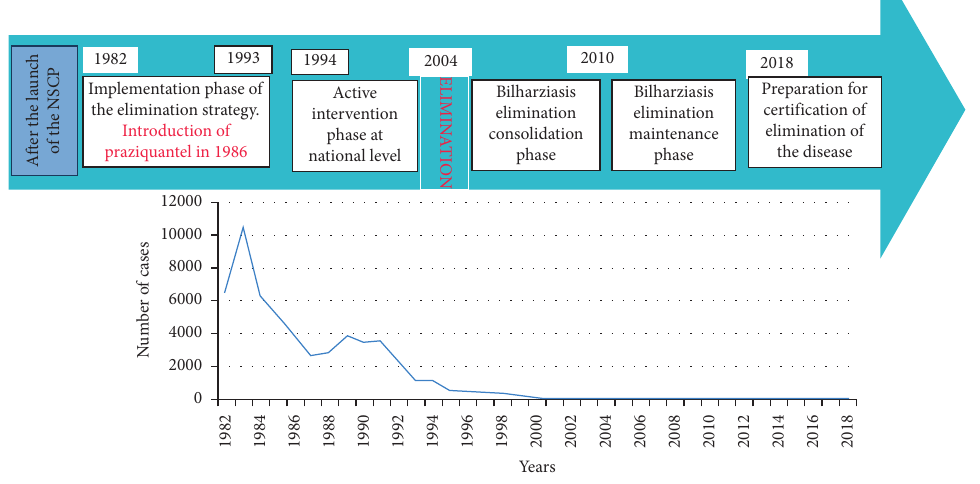
Figure 2: Evolution of schistosomiasis after development of the NSCP.